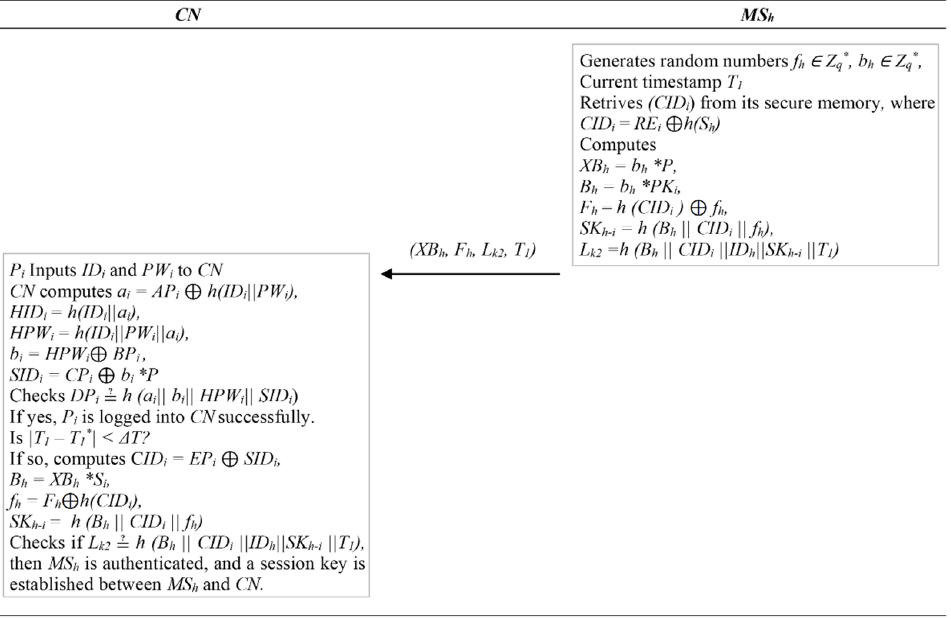
Figure 5. Authentication P-II.